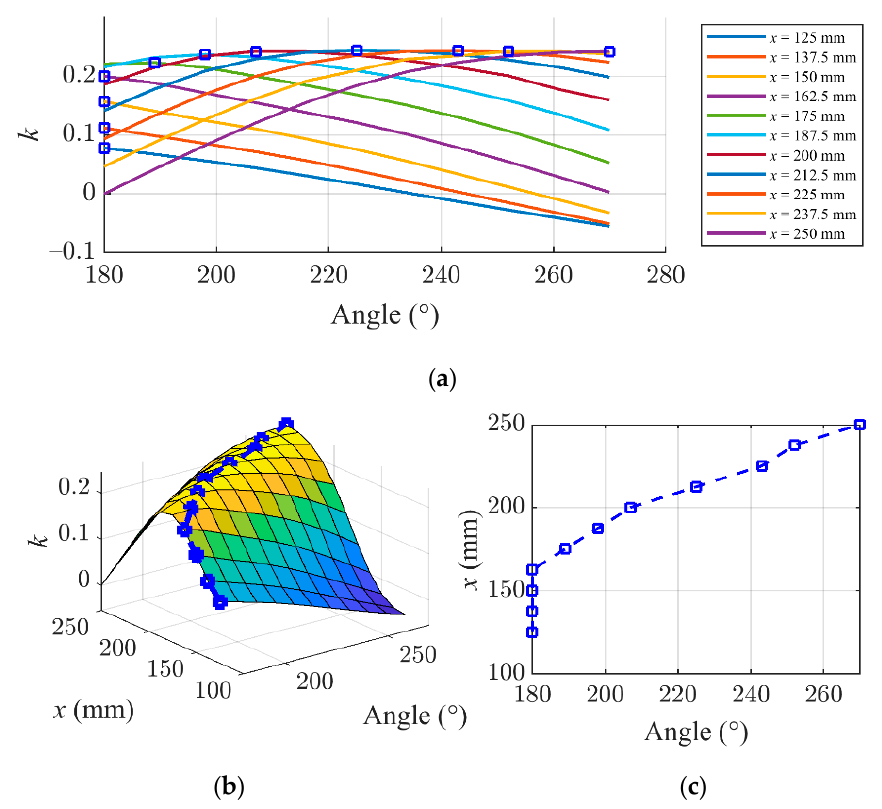
Figure 11. Simulation results of optimal movement trajectory: ( a ) coupling coefficients for different receiver coil angles, ( b ) surface with the optimal trajectory of movement and ( c ) optimal trajectory.